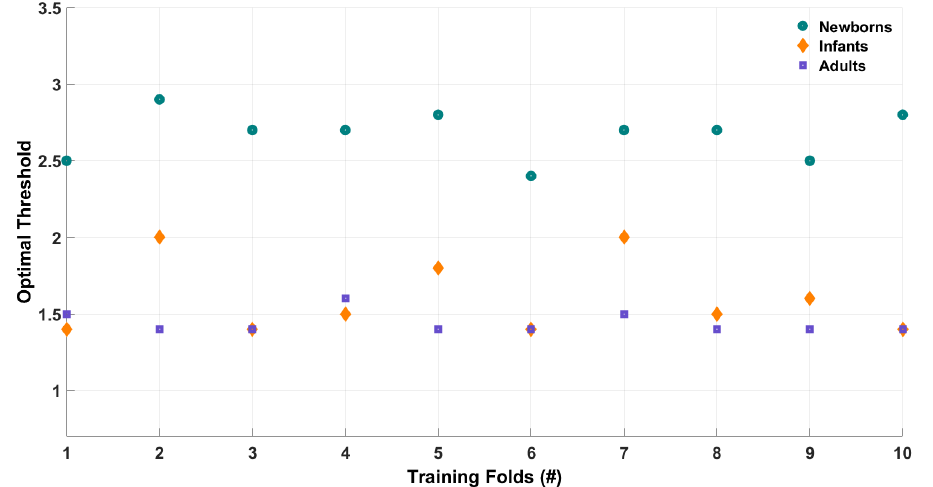
Figure 6. Summary of optimal range of LOF thr for different populations. For newborns (low SNR data), a relaxed threshold of 2.6 is optimal, whereas, for infants (better SNR data), a value of 1.6 is found to be optimal. Finally, for adults (high SNR data), a conservative threshold of 1.4 is